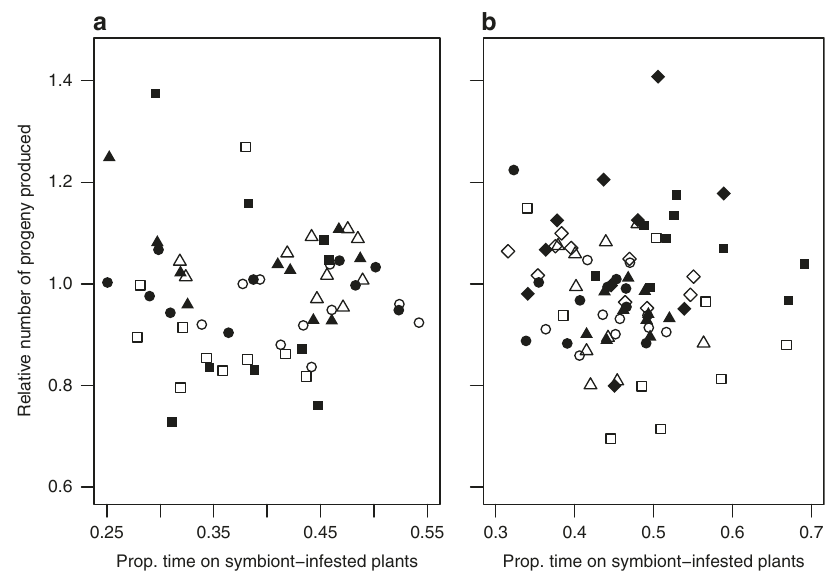
Fig. 2 Relationship between aphid vigour and parasitic wasp response. Relationship between the relative number of progeny produced by symbiont- carrying and symbiont-free Acyrthosiphon pisum aphids on Vicia faba plants, and the mean proportion of time spent by parasitic wasps Aphidius ervi above symbiont-infested plants. a Tests with the symbiont H. defensa . These test include natural symbiont infections where the symbiont was removed with antibiotics in strains 101 (empty squares), 132 (solid squares) and 302 (empty triangles); arti fi cial injections of strains 132 (solid triangles) and 404 (empty circles); test for systemic release of volatiles with an arti fi cial injection of strain 132 (solid dots). b Tests with the other symbiont species. These include natural Regiella insecticola infections where the symbiont was removed with antibiotics in strains 319 (empty squares) and 126 (solid squares), and arti fi cial injections of R. insecticola strains 319 (empty triangles) and 313 (solid triangles), Spiroplasma strains 227 (empty circles) and 237 (solid dots), Serratia symbiotica strain 619 (empty diamonds) and Rickettsiella strain 620 (solid diamonds). Spearman ’ s rank correlation tests for these relationships were never signi fi cant as shown in Supplementary Table